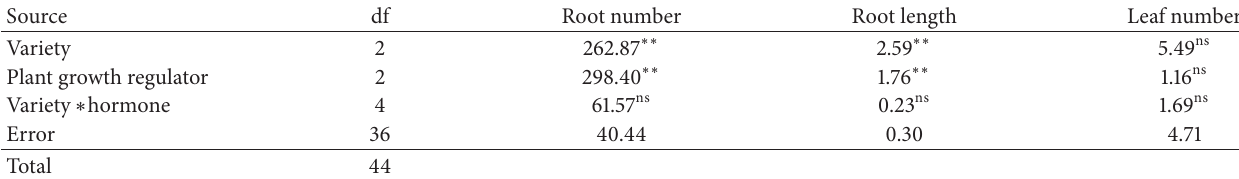
Table 8: Mean square from analysis of variance for plant growth regulators on day 14.